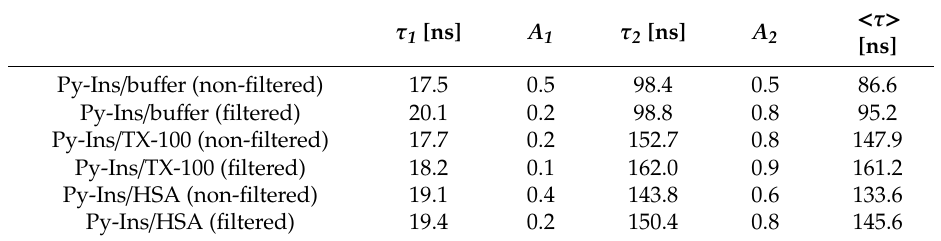
Table 1. Best fit parameters and average lifetimes < τ > for Py-Ins fluorescence decays in bu ff er, TX-100 and HSA solutions, according to bi-exponential